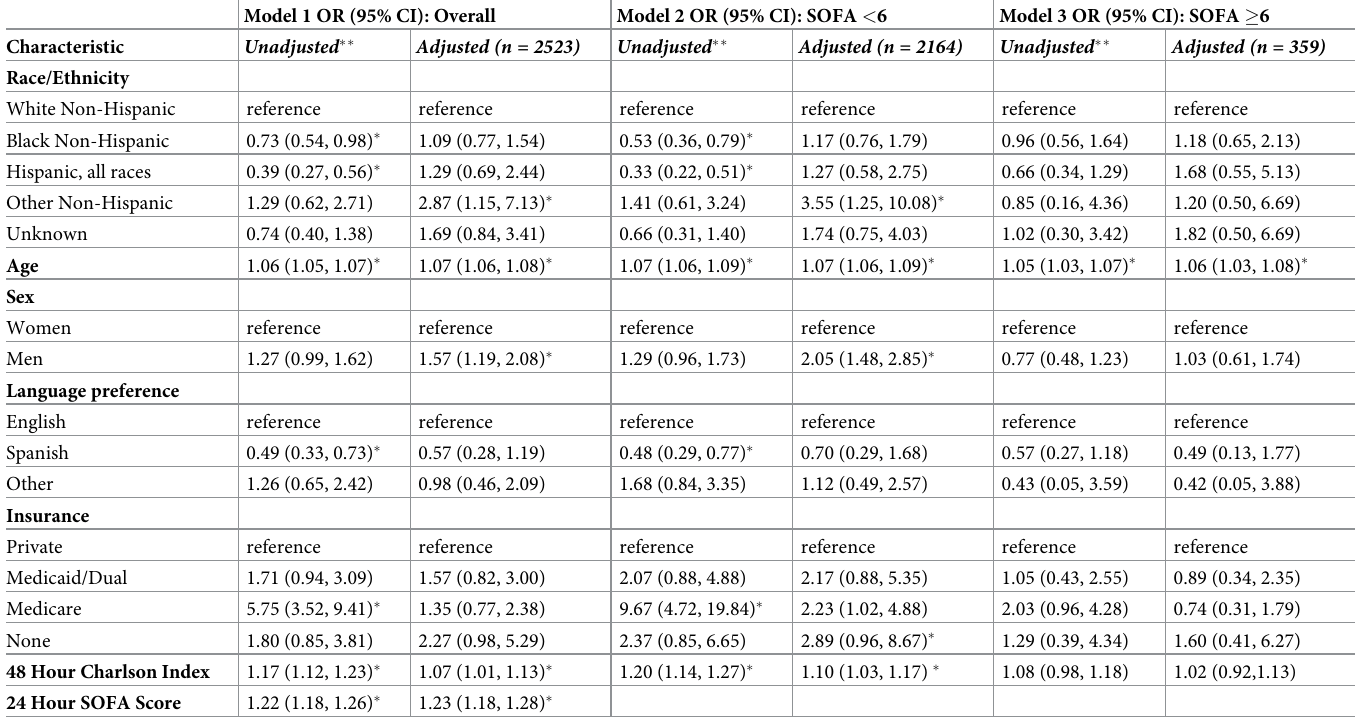
Table 3. Factors associated with in-hospital mortality, stratified by 24-hour SOFA score ��� . Model 1 OR (95% CI): Overall Model 2 OR (95% CI): SOFA <